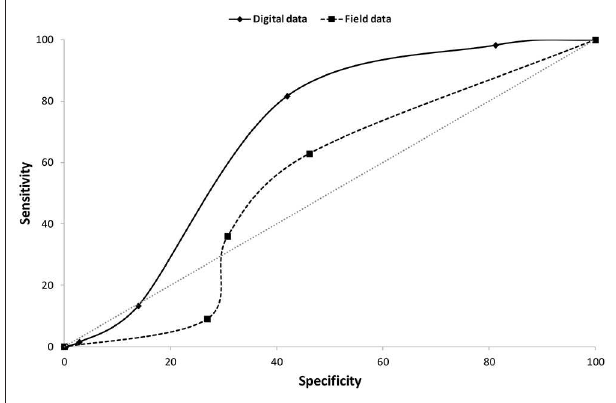
FIGURE 9 | Receiver operating characteristic curves comparing the prediction accuracy of the digital data vs. the field data for HGM type in the study area.